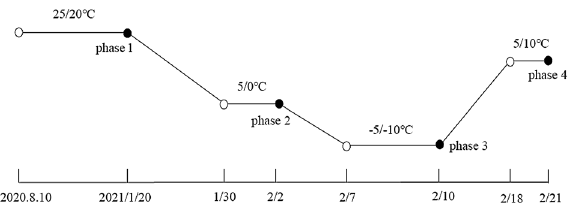
Figure 1. Schematic diagram of sampling in four test phases. Black dots for phases 1 to 4 represent sampling times in each